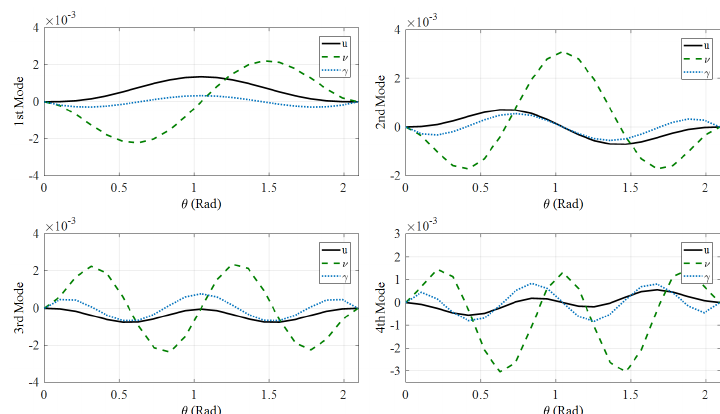
Figure 6. Displacement of nodal points of the curved beam without absorber for the first four modes (C-C)